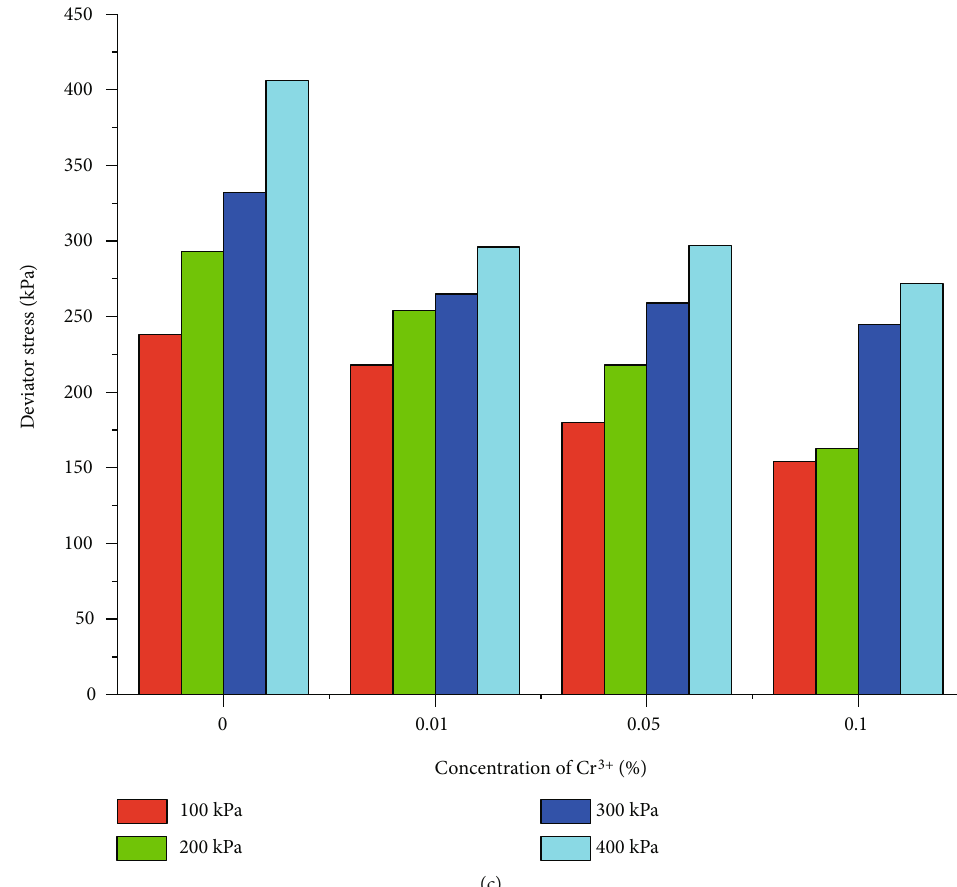
Figure 3: Changes of deviatoric stress under di ff erent con fi ning pressures. (a) The initial dry density is 1.35g/cm 3 . (b) The initial dry density is 1.40g/cm 3 . (c) The initial dry density is 1.45g/cm 3